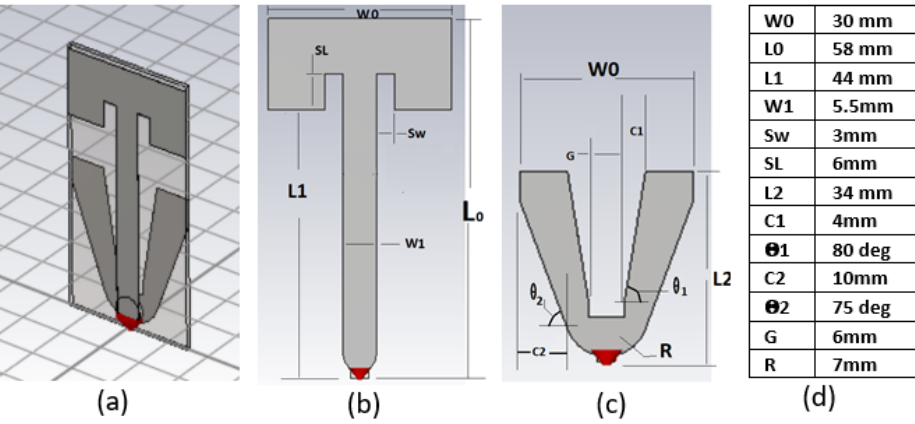
Figure 3. Proposed antenna structure: ( a ) whole structure, ( b ) long-structure, ( c ) short-structure, and ( d ) table of dimensions.